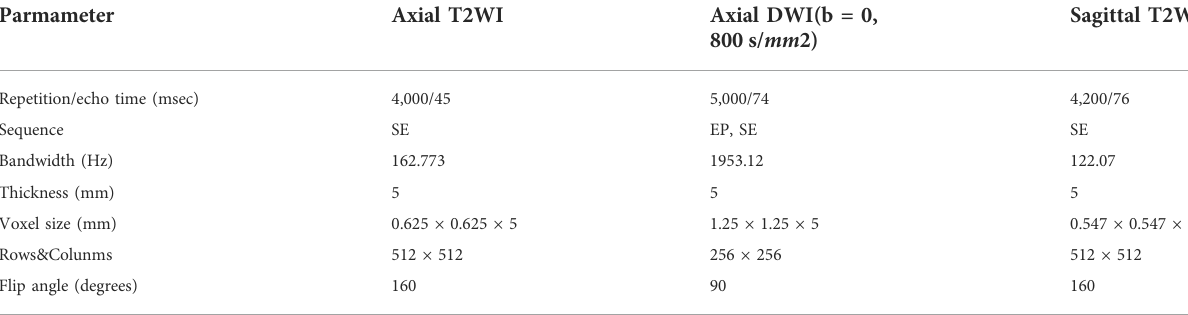
TABLE 2 Details of parameters for 1.5 Optima MR360 imaging protocols.